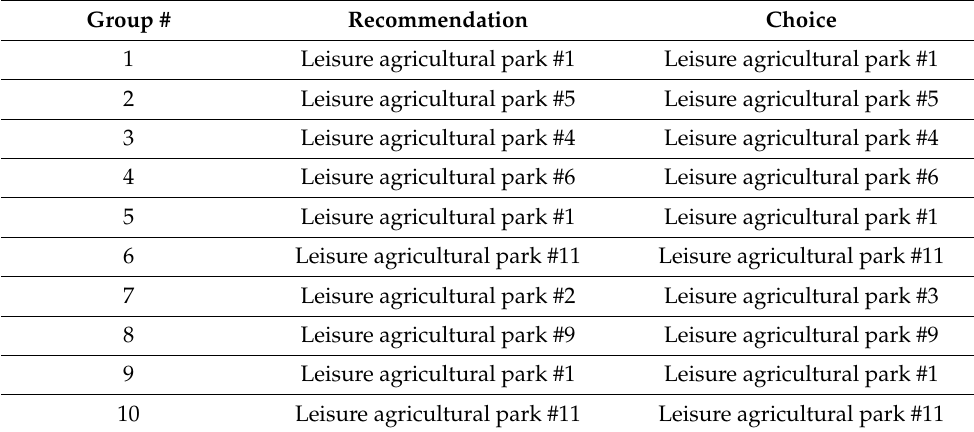
Table 10. Recommendation results to ten traveler groups.